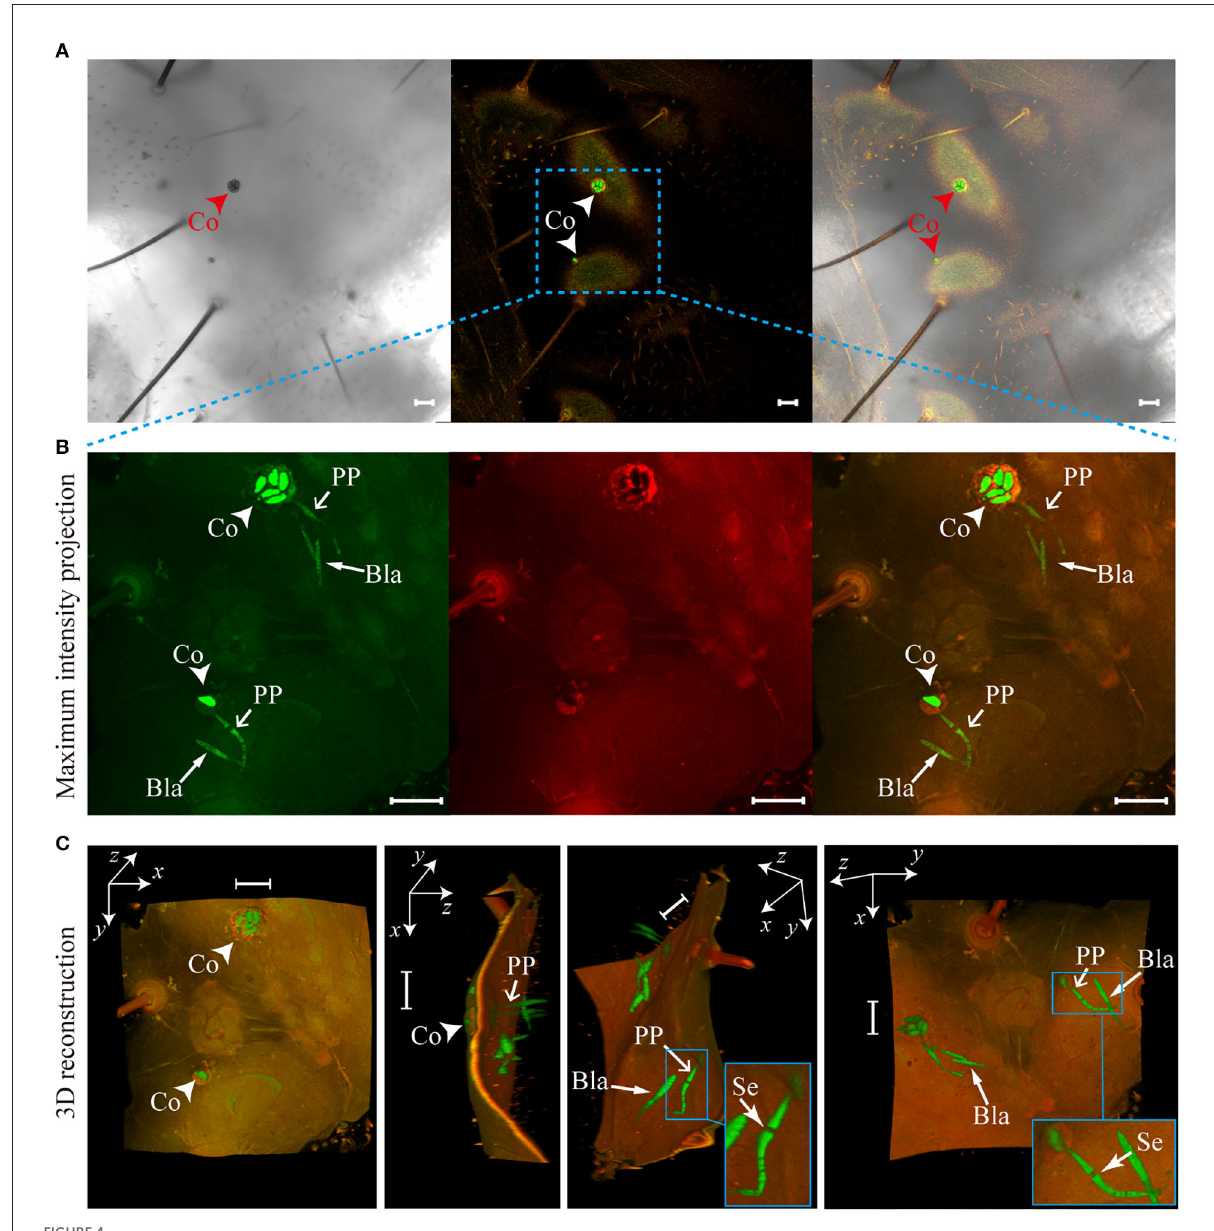
FIGURE4 Penetration pegs directly derived from Ophiocordyceps sinensis conidia punctured the teguments of Thitarodes xiaojinensis larvae. (A) O. sinensis conidia on the epicuticles of T. xiaojinensis larvae. (B) Maximum intensity projections of the z -axial stacks [noted region in (A) ]. (C) Three-dimensional (3D) reconstruction of the noted region in (A) using Fiji software. Co, conidium; PP, penetration peg; Se, septum; Bla, blastospore. Scale bar, 20 µ m.